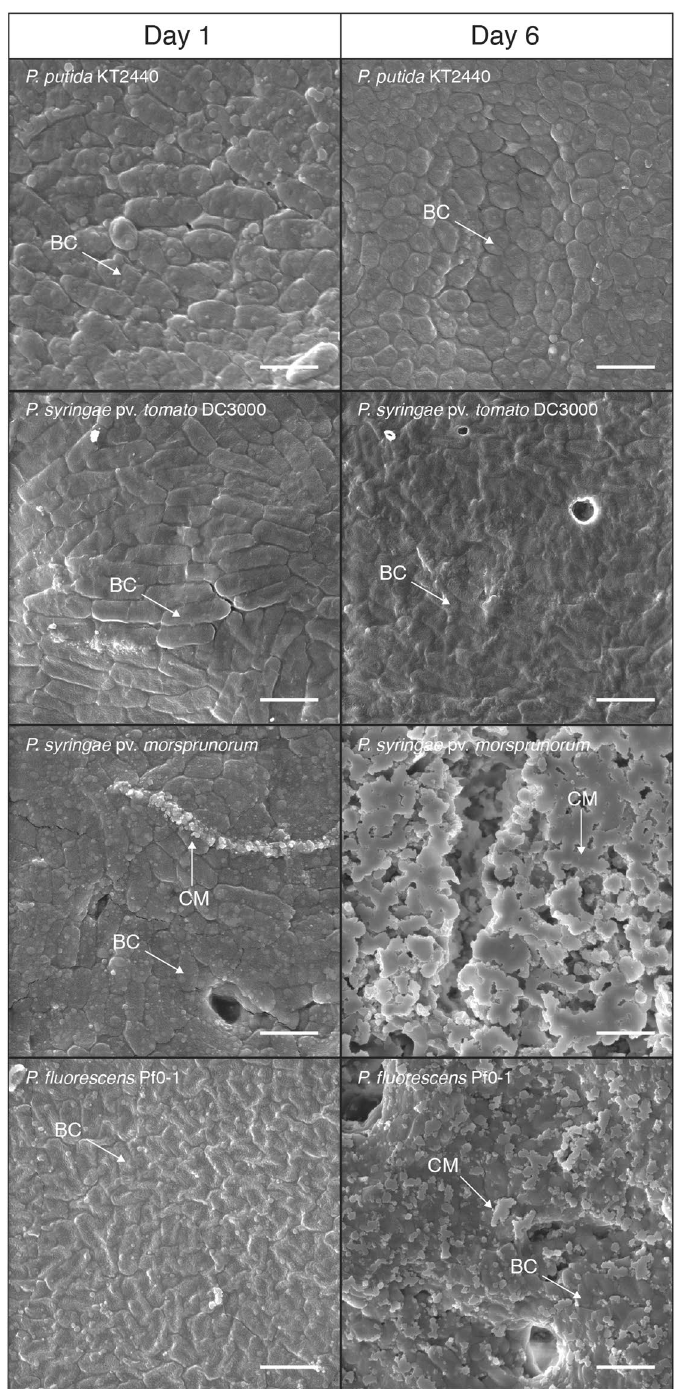
Figure 5. SEM images at 18,000x magnification of colon y surface for P. putida KT2440, P. syringae pv. morsprunorum 5795, P. syringae pv. tomato DC3000, and P. fluorescens Pf0-1 at 12 hours and six days of growth. 2 µ m scale bars are indicated in the lower right-hand corner of the images. An arrow labelled “CM” points to calcium phosphate on the surface of cells are included on each image where calcium phosphate is thought to be present. An arrow labelled “BC” points to bacterial cells in each image. Imaging of cells with SEM was performed three times using separate biological replicates for each image. This image is representative of what was observed with the other